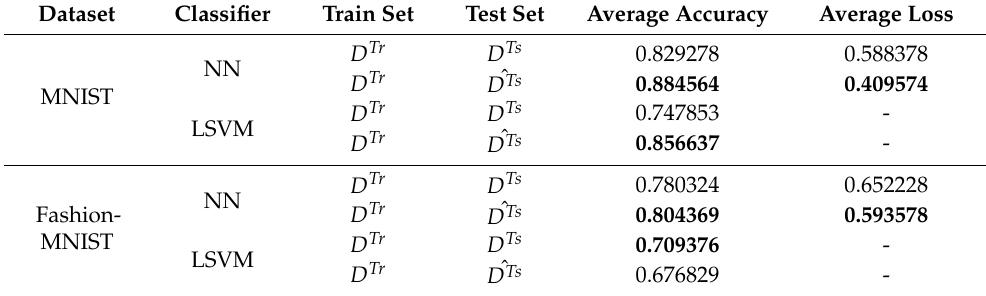
Table 5. Set-1 pilot experiment results. D Tr is the original training set (without transformation), D Ts is the original unlabeled test set (without transformation), and ˆ D Ts is the transformed (using our model) unlabeled test set. Bolded values indicate the best results achieved in each